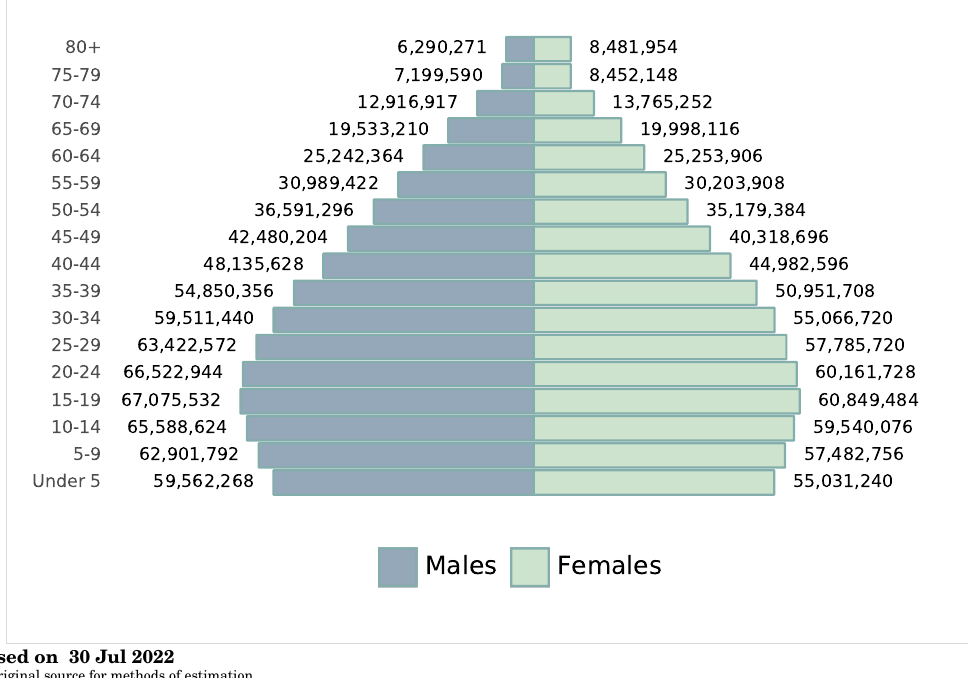
Figure 2: Population pyramid of India for 2022